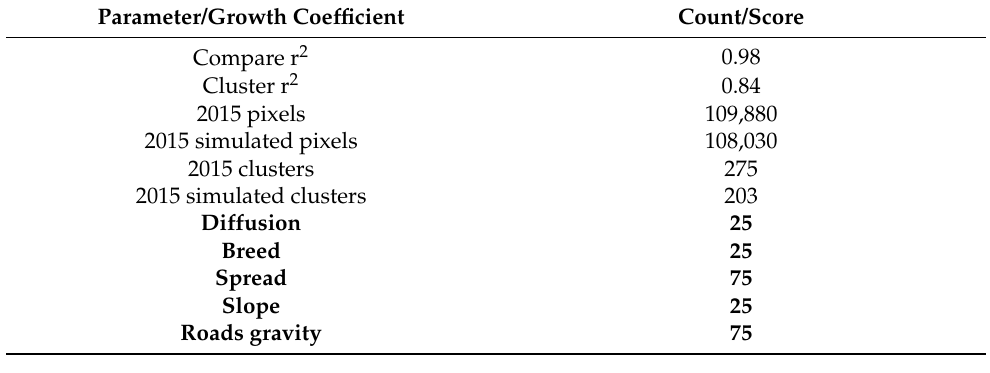
Table 4. Calibration accuracy results for Greater Irbid Municipality. The compare and cluster scores are given along 52 with the actual and simulated number of urban pixels, and the actual and simulated number of urban clusters for 53 2015. The best growth coefficients scores are out of 100.